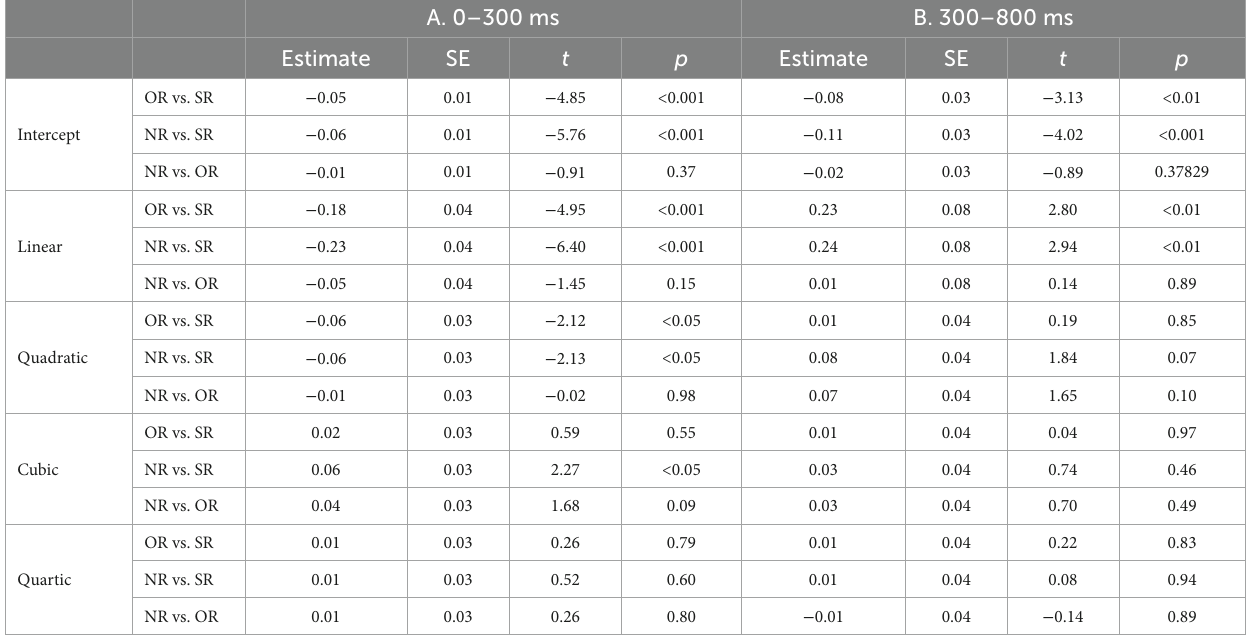
TABLE 1 Pairwise parameter-specific estimation results for the time windows of 0–300 ms (A) and 300–800 ms